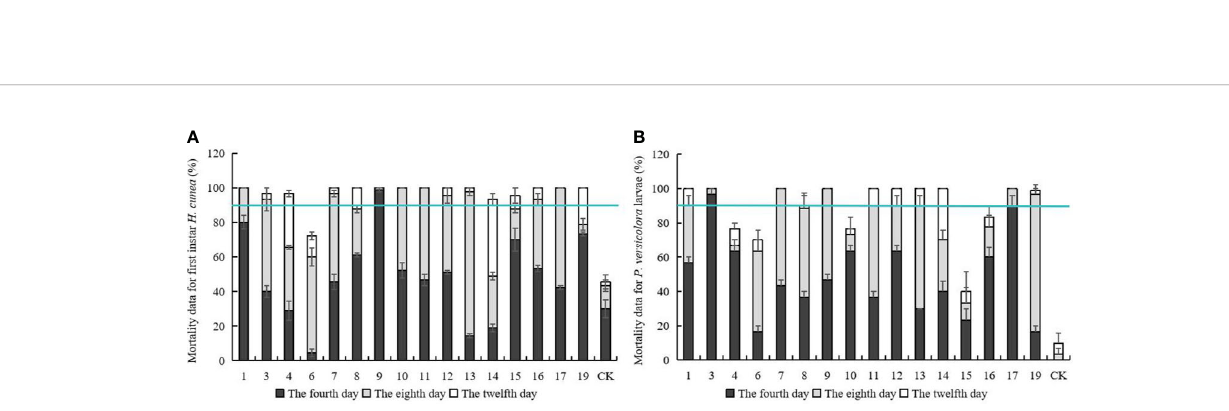
FIGURE 3 | Mortality data for fi rst instar H. cunea and Mortality data for P. versicolora larvae feeding on transgenic and control plant lines. (A) Mortality data for fi rst instar H. cunea feeding on transgenic and control plant lines. (B) Mortality data for P. versicolora larvae feeding on transgenic and control plant lines. 1, 3, 4, 6, 7, 8, 9, 10, 11, 12, 13, 14, 15, 16, 17, and 19 respectively represent the corresponding line numbers of the 16 transgenic poplar lines with good growth; CK, non- transgenic poplar. The number of the fi rst instar h. cunea and p. versicolora larvae bean on transgenic and control plant lines death was counted daily and the mortality rate was calculated. The fourth day, the eighth day, the twelfth day represents the cumulative death rate of four, eight and twelve days. Data are means of three biological replicates of each line. Error bars represent the standard deviation of the mean. The horizontal line is the 90 percent cumulative mortality